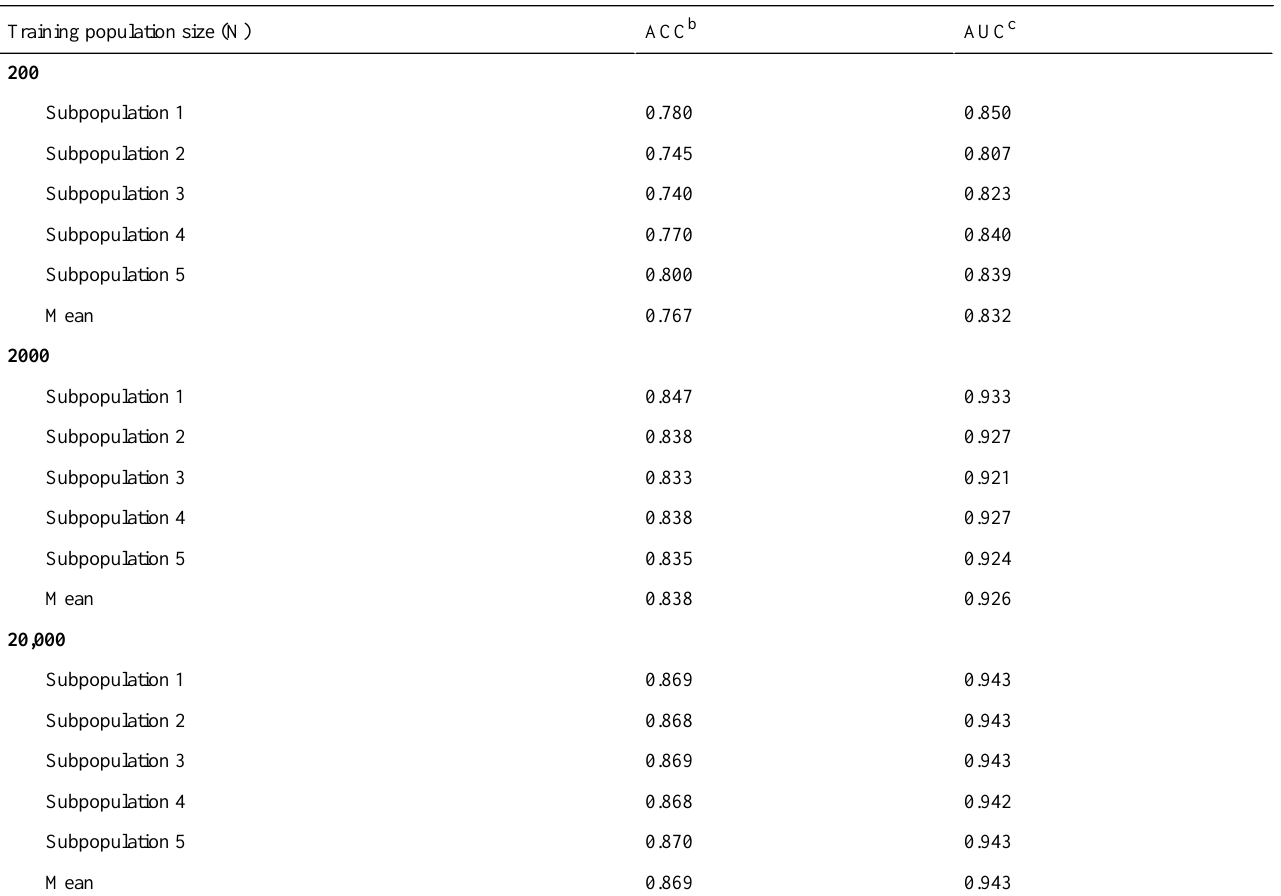
Table 6. Trends of model accuracy with respect to varying training population size a